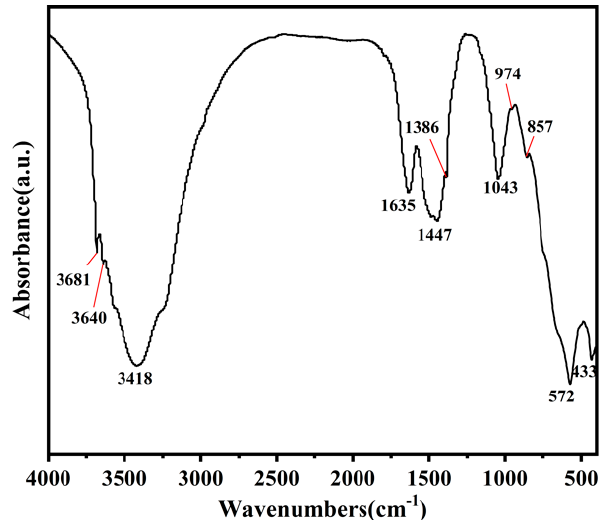
Figure 1. FT-IR spectra of magnesium cement-based photocatalytic materials.